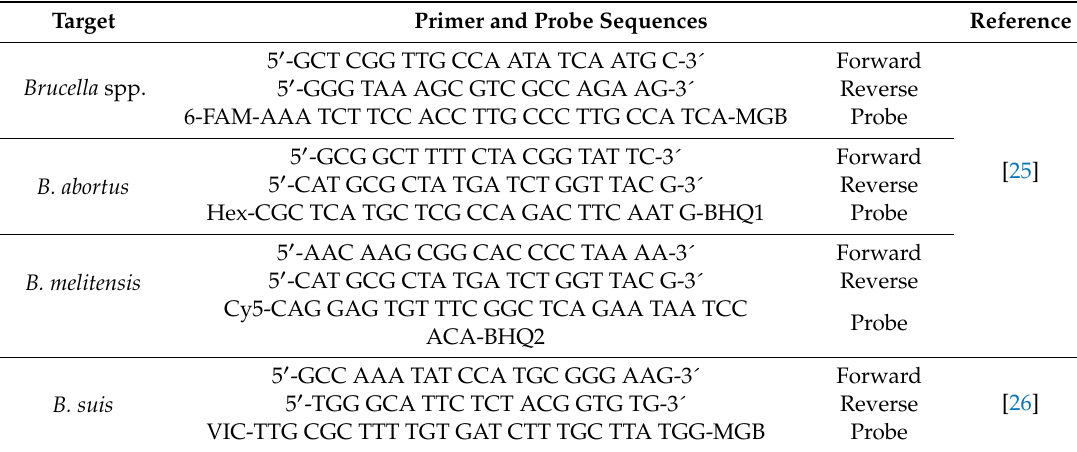
Table 1. Primer and probe sequences used in real-time PCR assays for the detection of Brucella spp., B. abortus , B. melitensis and B. suis in camel sera,